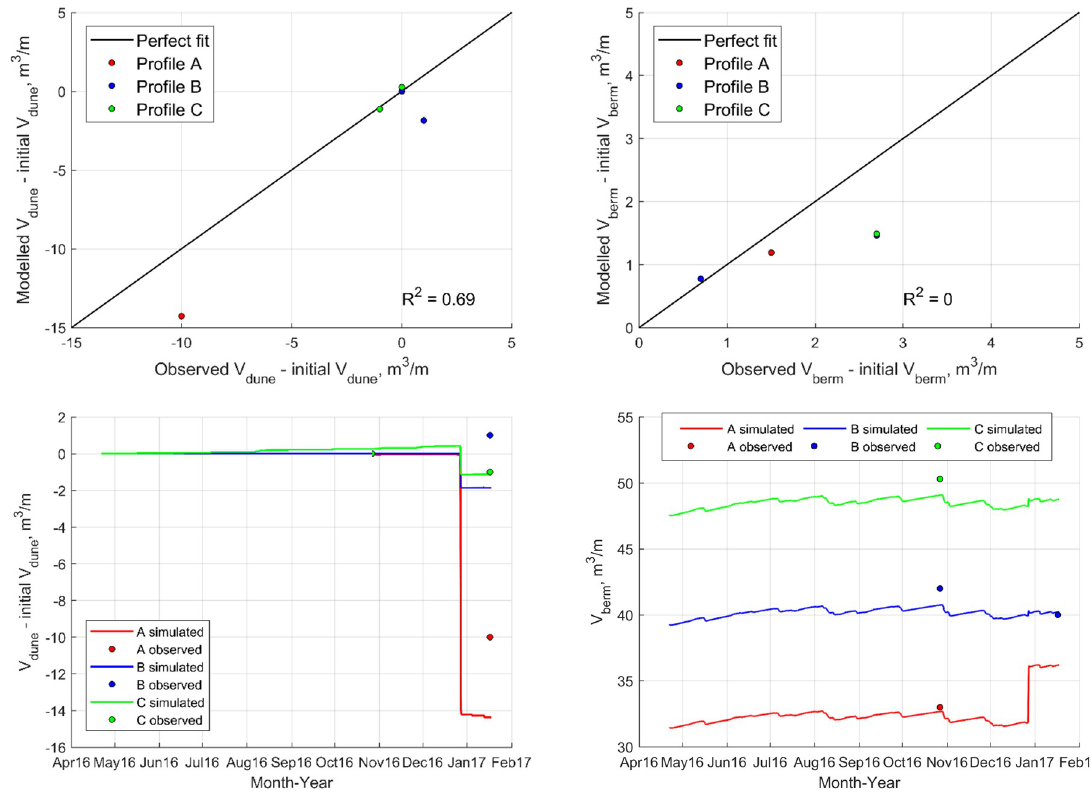
Fig 14. Dune and beach volume evolution for validation period.